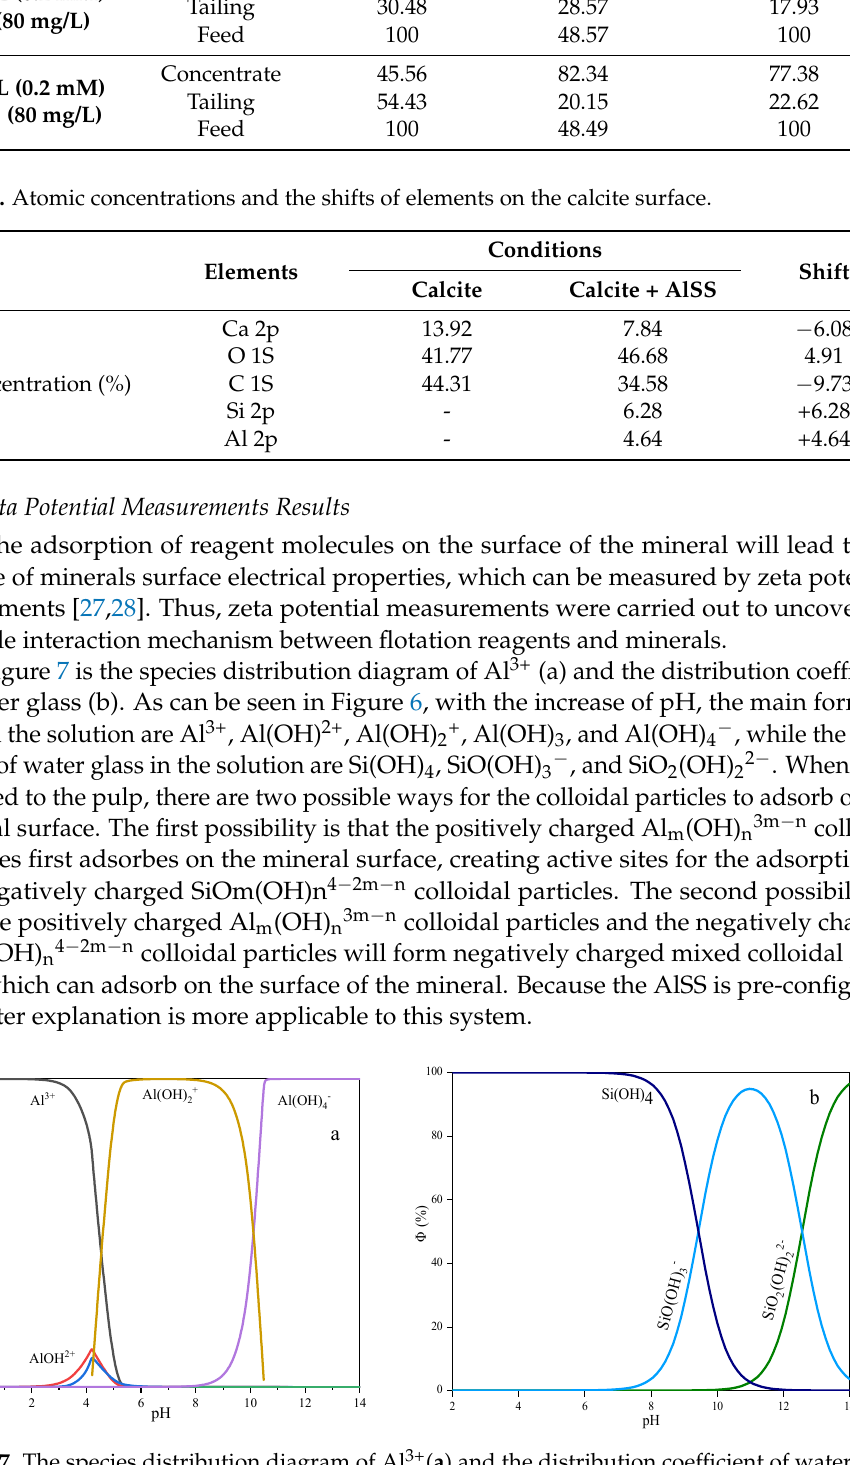
Figure 7. The species distribution diagram of Al 3+ ( a ) and the distribution coefficient of water glass ( b ) as a function of pH.